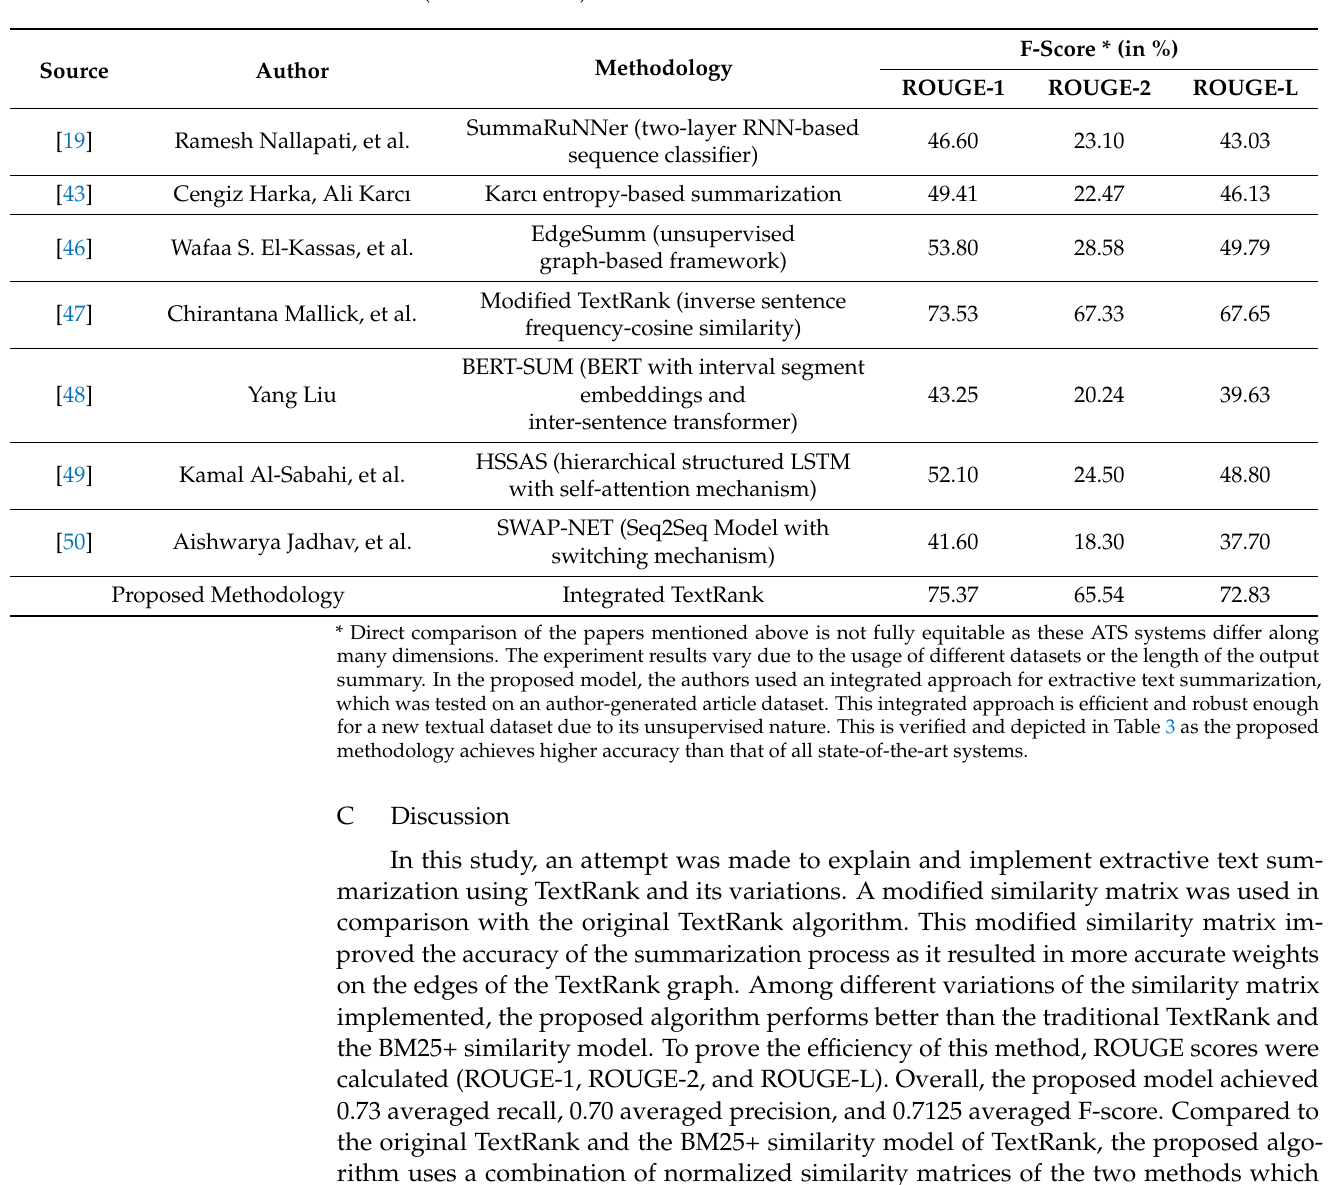
Table 3. Comparison of the proposed model with various state-of-the-art methods based on average F-scores (ROUGE